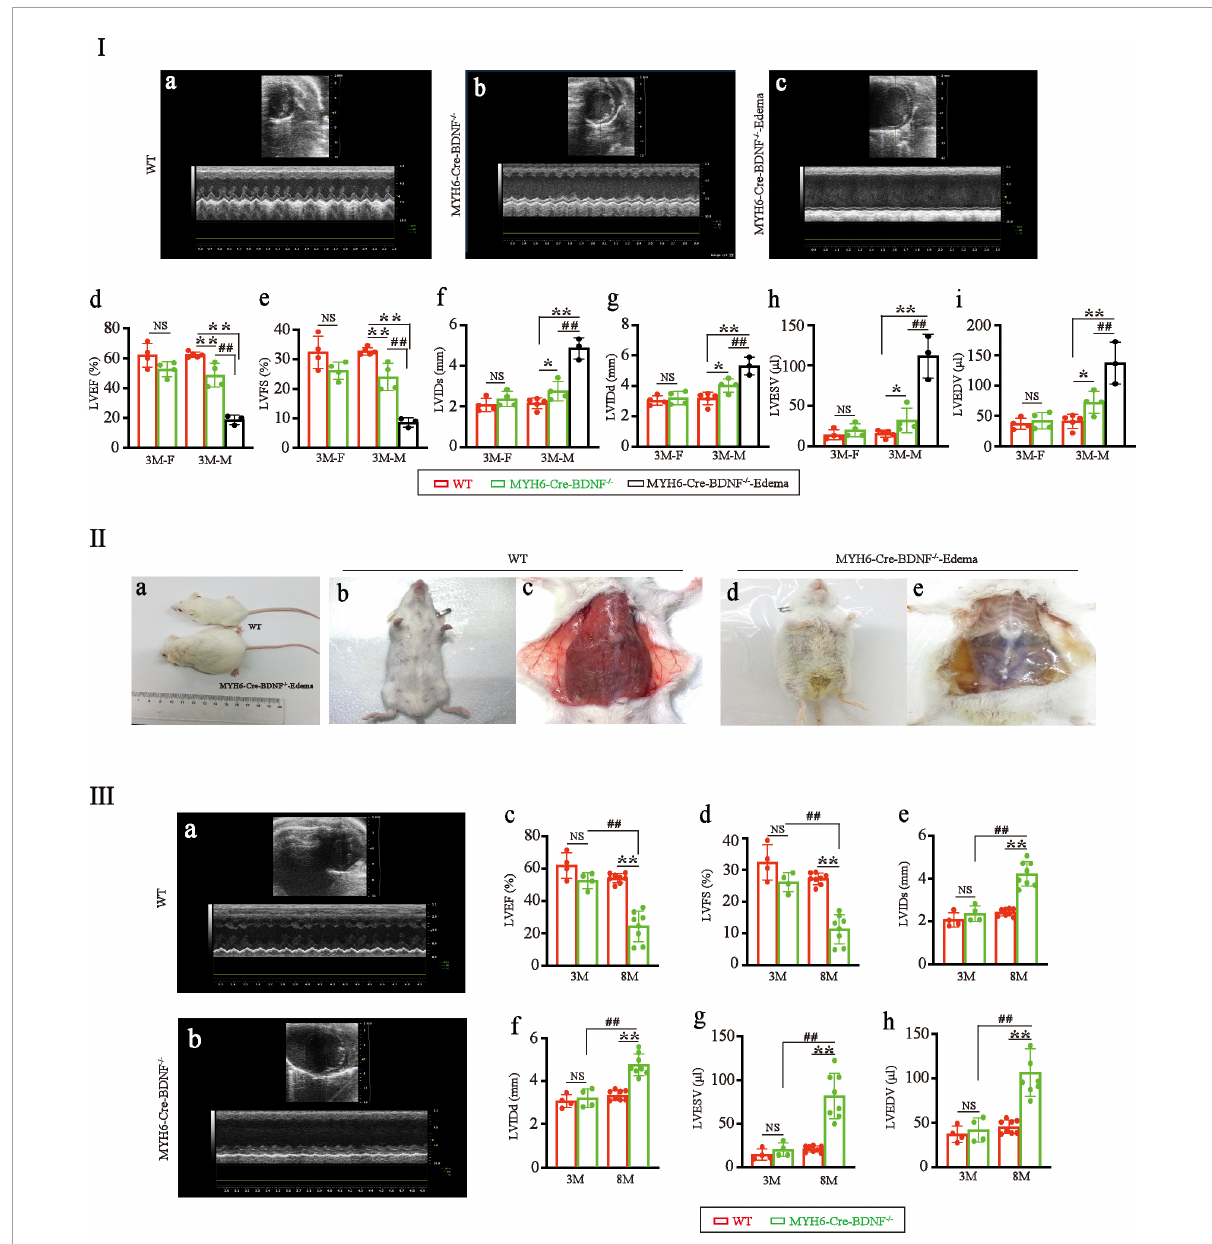
FIGURE2 Cardiac dysfunction and osmotic edema are found in adult MYH6-Cre-BDNF − / − mice: (I) Representative echocardiography of WT hearts (a) , MYH6-Cre-BDNF − / − hearts (b) and MYH6-Cre-BDNF − / − -edema hearts (c) . Echocardiography showed that in 3-month-old males, the left ventricular ejection fraction (LVEF) (d) and left ventricular fractional shortening (LVFS) (e) of MYH6-Cre-BDNF − / − hearts were significantly lower than those of WT hearts, while the left ventricular end-systolic internal diameter (LVIDs) (f) , left ventricular end-diastolic internal diameter (LVIDd) (g) , left ventricular end-systolic volume (LVESV) (h) and left ventricular end-diastolic volume (LVEDV) (i) of MYH6-Cre-BDNF − / − hearts were significantly higher than those of WT hearts. Three-month-old osmotic edema MYH6-Cre-BDNF − / − male mice had worse cardiac function parameters (LVEF, LVFS, LVIDs, LVIDd, LVESV and LVEDV) than 3-month-old WT mice (a–i) . * p < 0.05, **, ## p < 0.01. n = 4 for the 3-month-old female WT and MYH6-Cre-BDNF − / − groups respectively; n = 5 and 4 for the 3-month-old male WT and MYH6-Cre-BDNF − / − groups. n = 3 for the 3-month-old male MYH6-Cre-BDNF − / − edema group. (II) Starting at 3 months of age, some MYH6-Cre-BDNF − / − mice exhibited osmotic edema (a,d,e) compared to WT mice (a–c) . (III) Representative echocardiography of 8-month-old WT hearts (a) and 8-month-old MYH6-Cre-BDNF − / − hearts (b) . The LVEF (c) and LVFS (d) of 8-month-old MYH6-Cre-BDNF − / − female hearts were significantly smaller than those of 8-month-old WT female hearts, 3-month-old MYH6-Cre-BDNF − / − female hearts and 3-month-old WT female hearts, while LVIDs (e) , LVIDd (f) , LVESV (g) , and LVEDV (h) of 8-month-old MYH6-Cre-BDNF − / − female hearts were significantly higher than those of 8-month-old WT female hearts, 3-month-old MYH6-Cre-BDNF − / − female hearts and 3-month-old WT female hearts. **, ## p < 0.01. n = 4 for the 3-month-old female WT and MYH6-Cre-BDNF − / − groups respectively; n = 8 for the 8-month-old female WT and MYH6-Cre-BDNF − / − groups